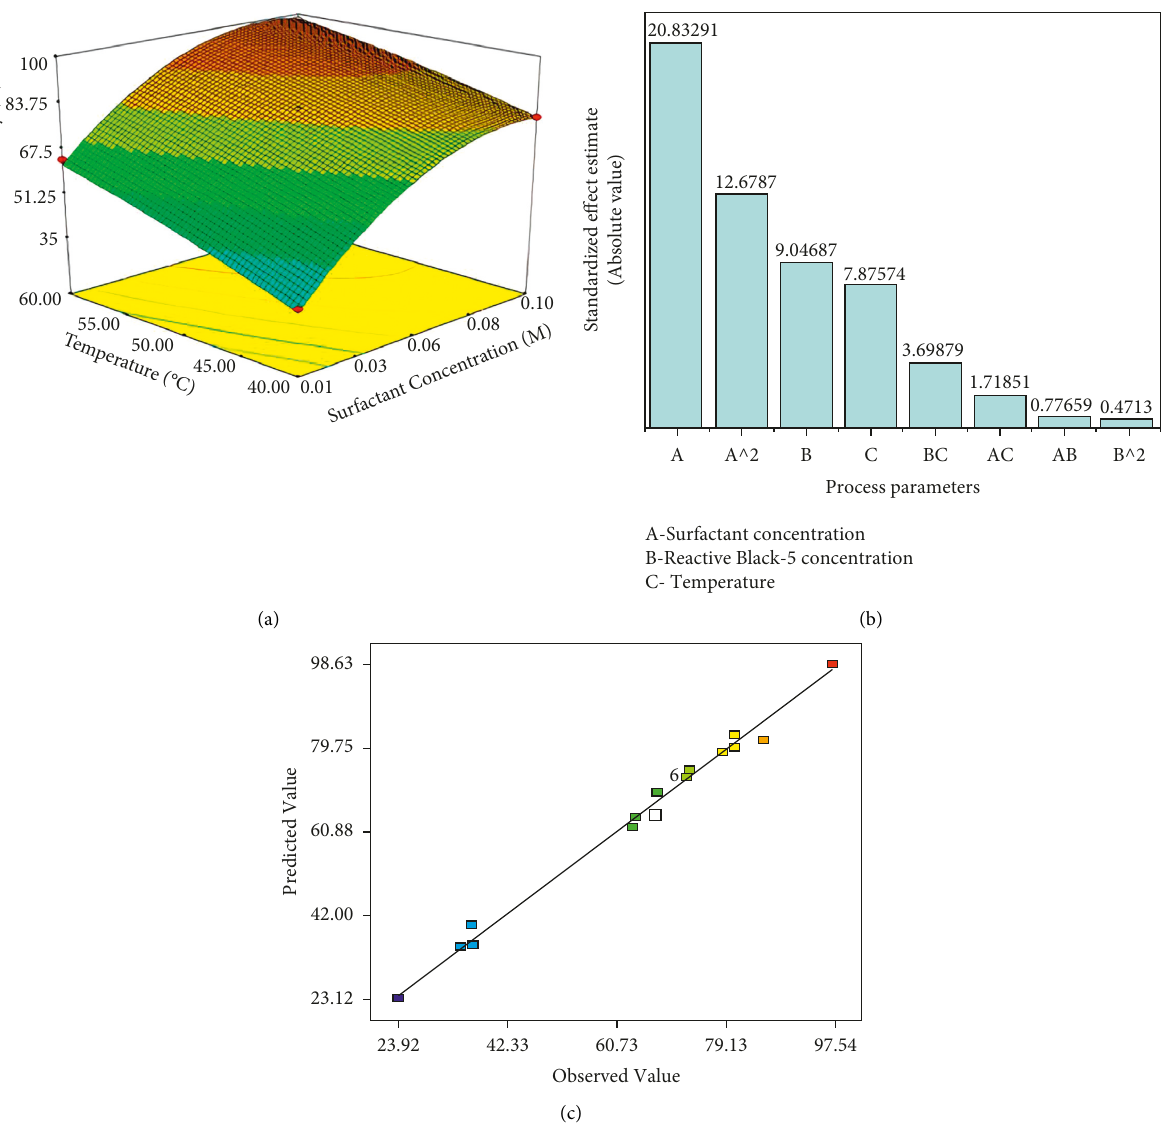
Figure 5: (a) Response surface for the phase volume ratio. (b) Effect of variables on the coacervate phase volume fraction. (c) Relationship between predicted and observed values of the phase volume